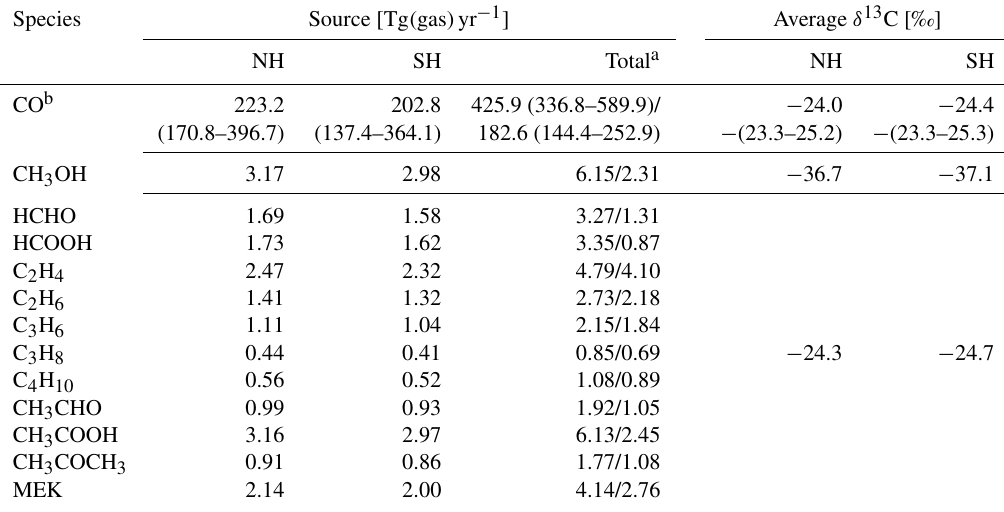
Table 3. Biomass burning emission sources strengths and their isotopic signatures.